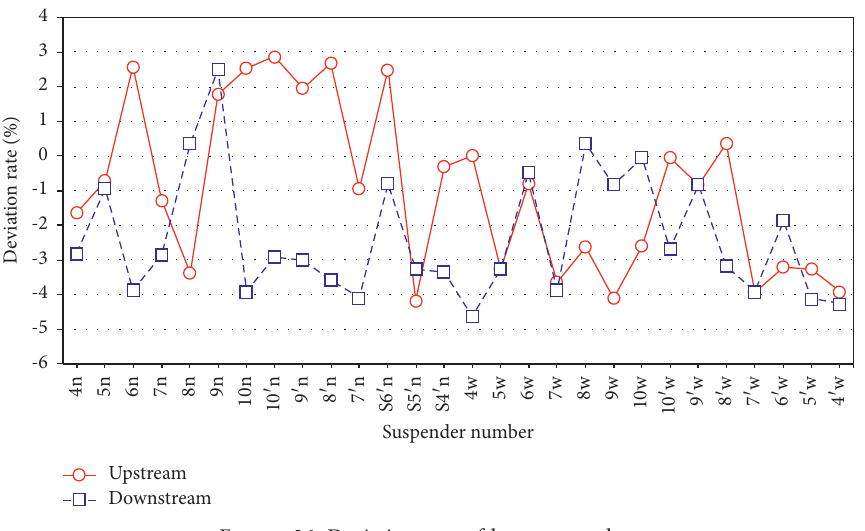
Figure 26: Deviation rate of long suspender. Table 8: Error between calculated cable force and actual cable force. Suspender no.